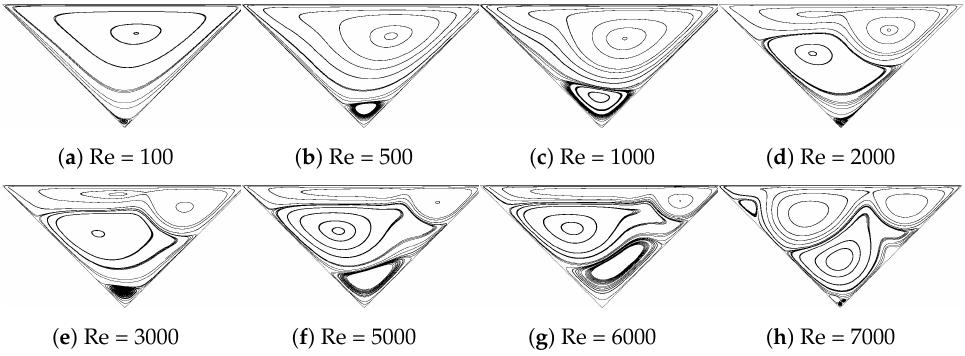
Figure 3. Steady solutions, streamlines describe vortical structures inside the right-angled isosceles triangular cavity at different Reynolds numbers, ranging from 100 to 7000.